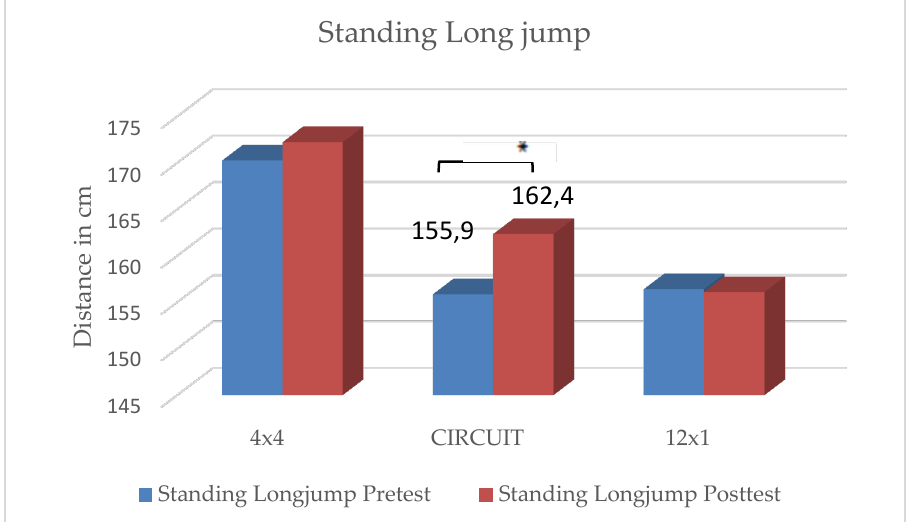
Figure 5. Changes in distance covered with standing long jump within intervention groups. * Significant difference between pre- and posttest ( p < 0.05).